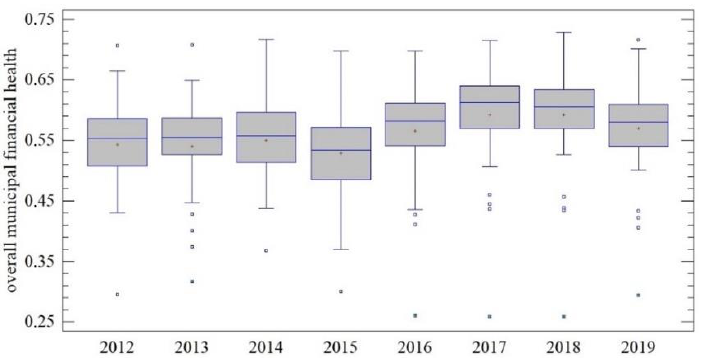
Figure 5. The overall financial health of municipalities based on four indicators (D1) during the